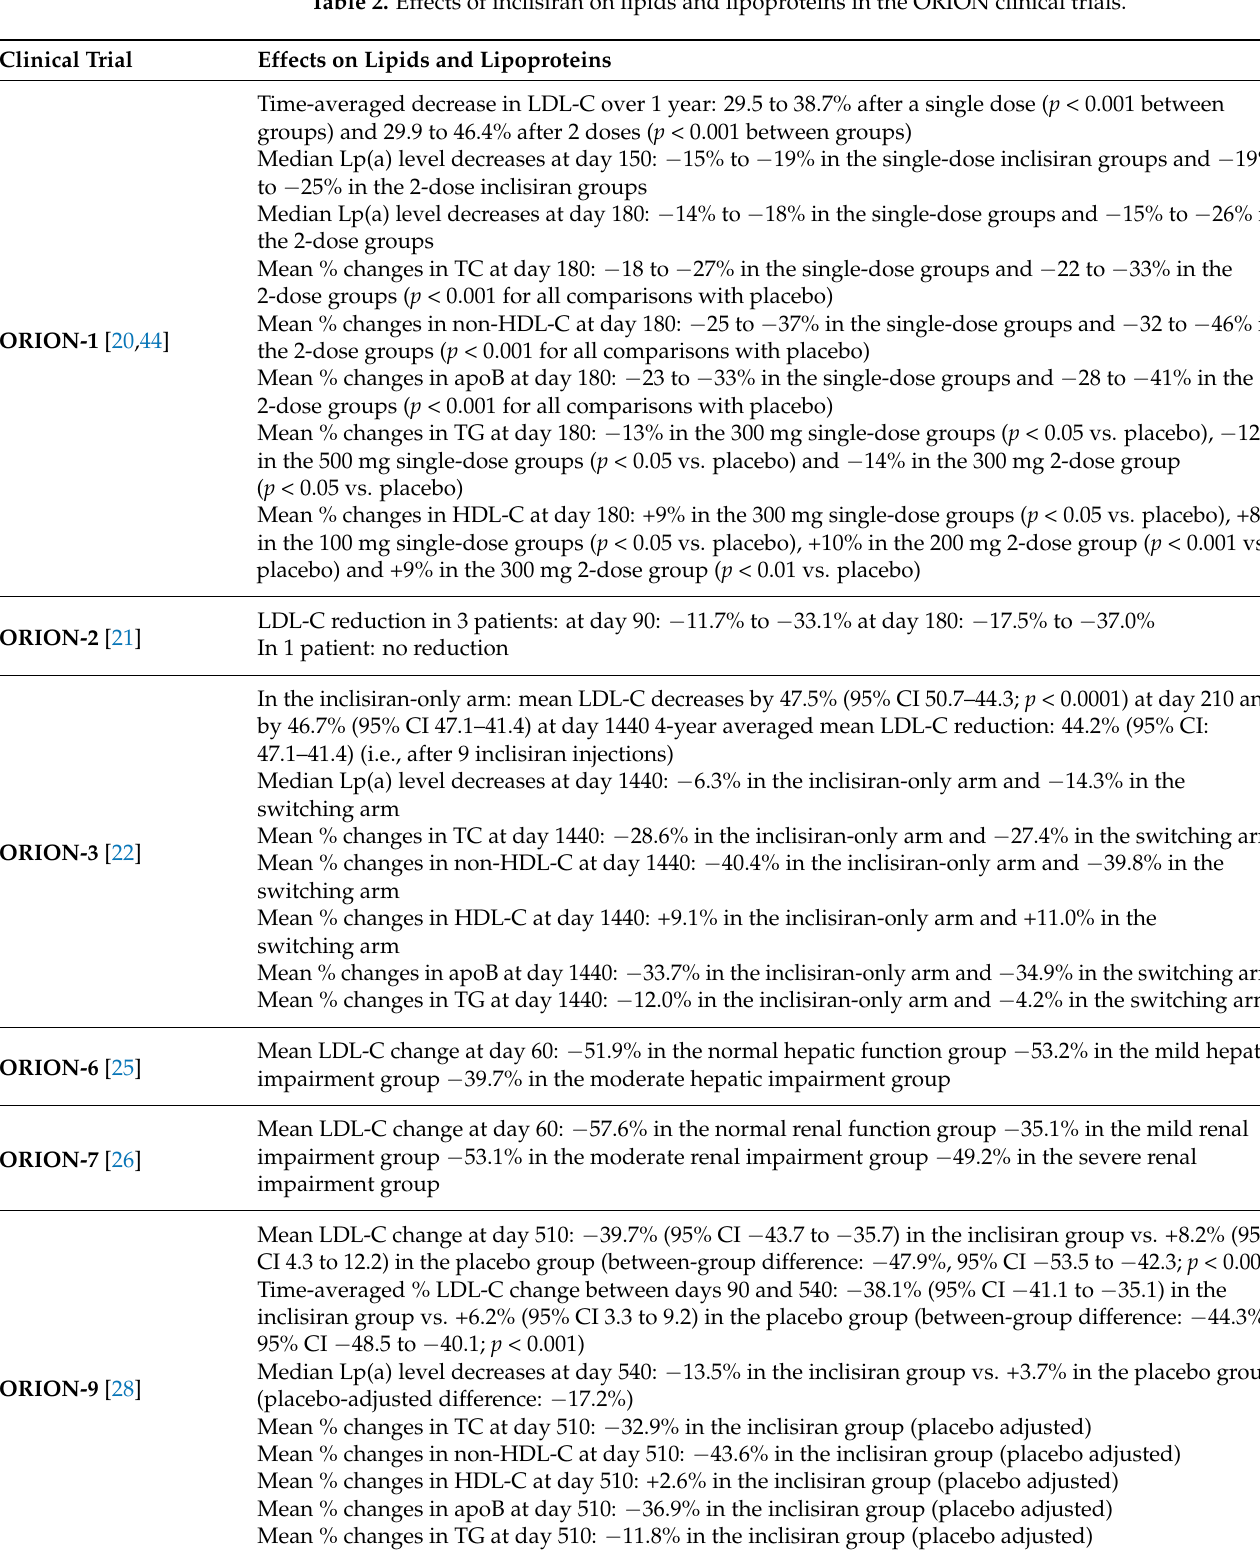
Table 2. Effects of inclisiran on lipids and lipoproteins in the ORION clinical